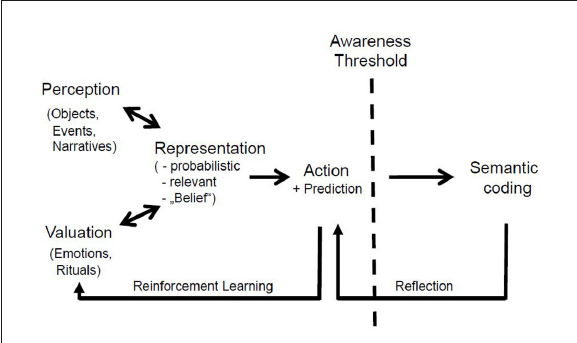
FIGURE1 The neural processes underlying believing below and above a person’s conscious awareness. The processes on the left evolve fast, within the range of milliseconds in cortico-subcortical brain structures, allowing for the formation and updating of beliefs and corresponding action generation. Perception pertains to environmental information, whereas valuation mediates the emotional valence. These processes can be the object of empirical neuroscience research. The neural processes on the right occur in the realm of conscious awareness and capitalize on verbalized information which can become the object of a person’s reflection or appraisal. Note that the participation in rituals provides an immediate emotional loading to such stereotypic events that are instructed by corresponding narratives. These putative processes have stimulated epistemic theories in the humanities since